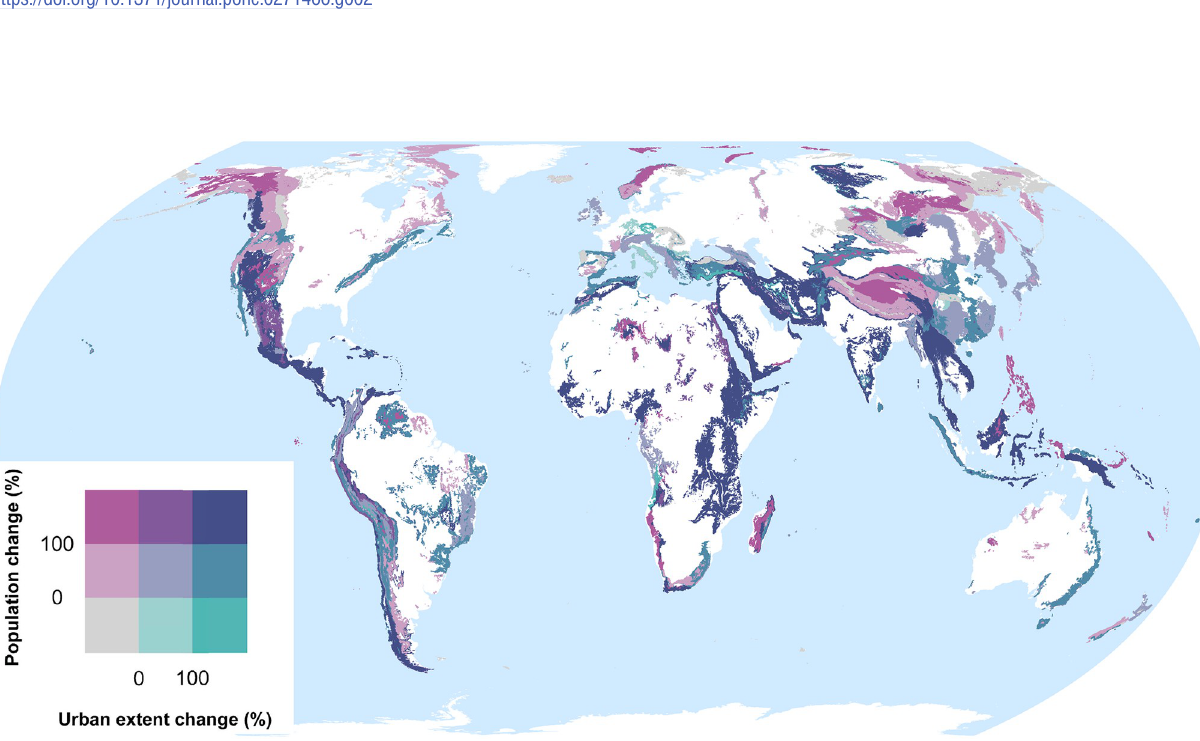
Fig 2. Growth in extent and population of Santiago, Chile, over recent decades according to GHS-POP population data and GUB urban extents.